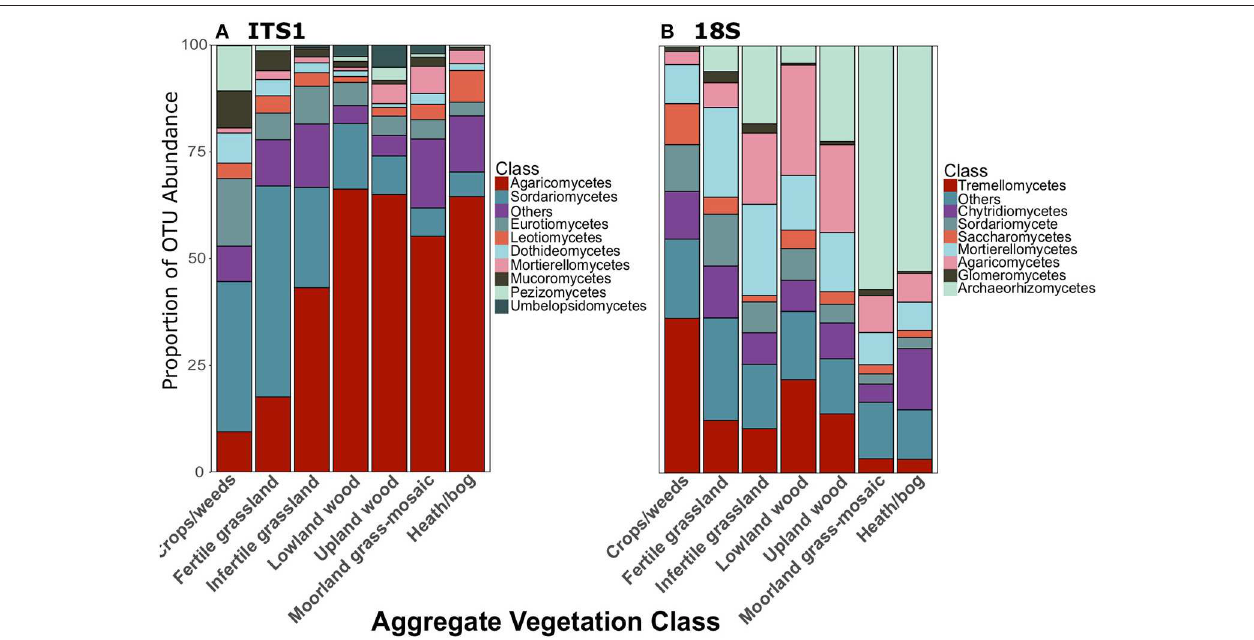
FIGURE 3 | Proportionate abundances of fungal OTUs for (A) ITS1 and (B) 18S data across Aggregate Vegetation Class. Aggregate Vegetation Classes are ordered from most (Crops/weeds) to least (Heath/bog) productive.